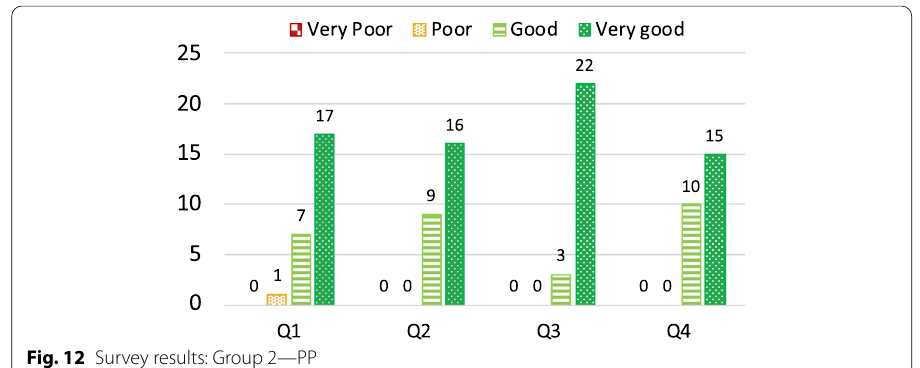
Fig. 12 Survey results: Group